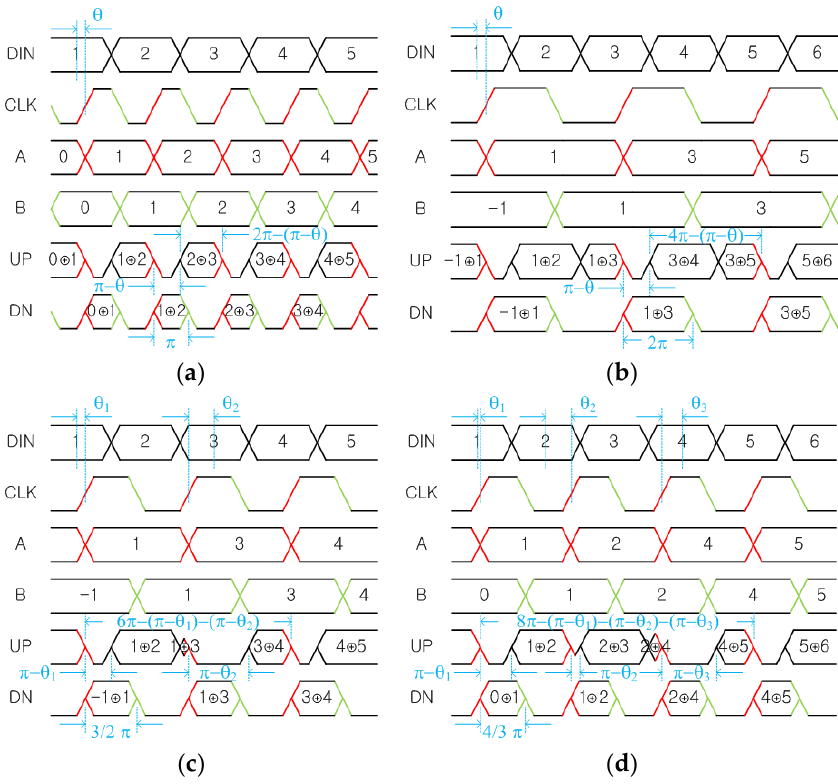
Figure 2. The timing diagrams of the full-rate linear PD when f CLK = 1/ n × f DATA and ( a ) n = 1, ( b ) n = 2, ( c ) n = 3/2 and ( d ) n = 4/3.